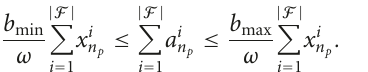
, x n , and y n p p p